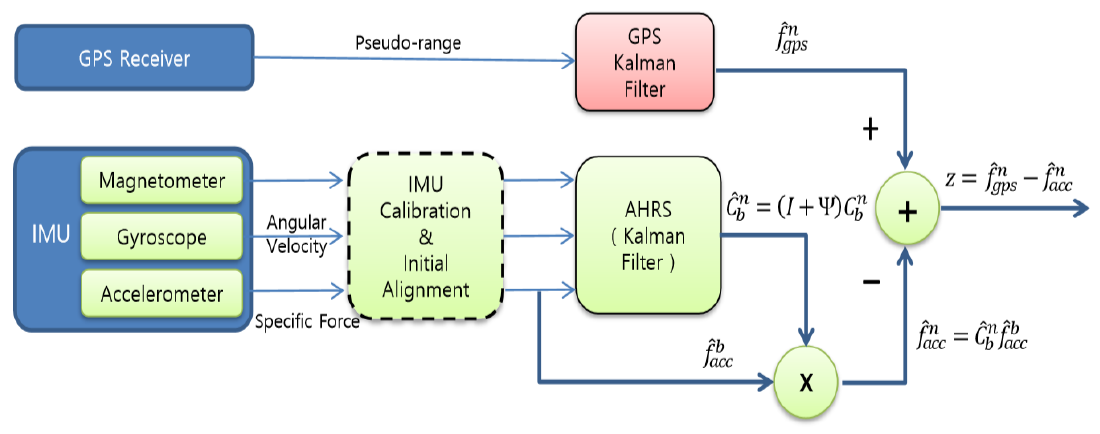
Figure 1. Block diagram to obtain the acceleration error from the Global Positioning System (GPS) receiver and accelerometer.